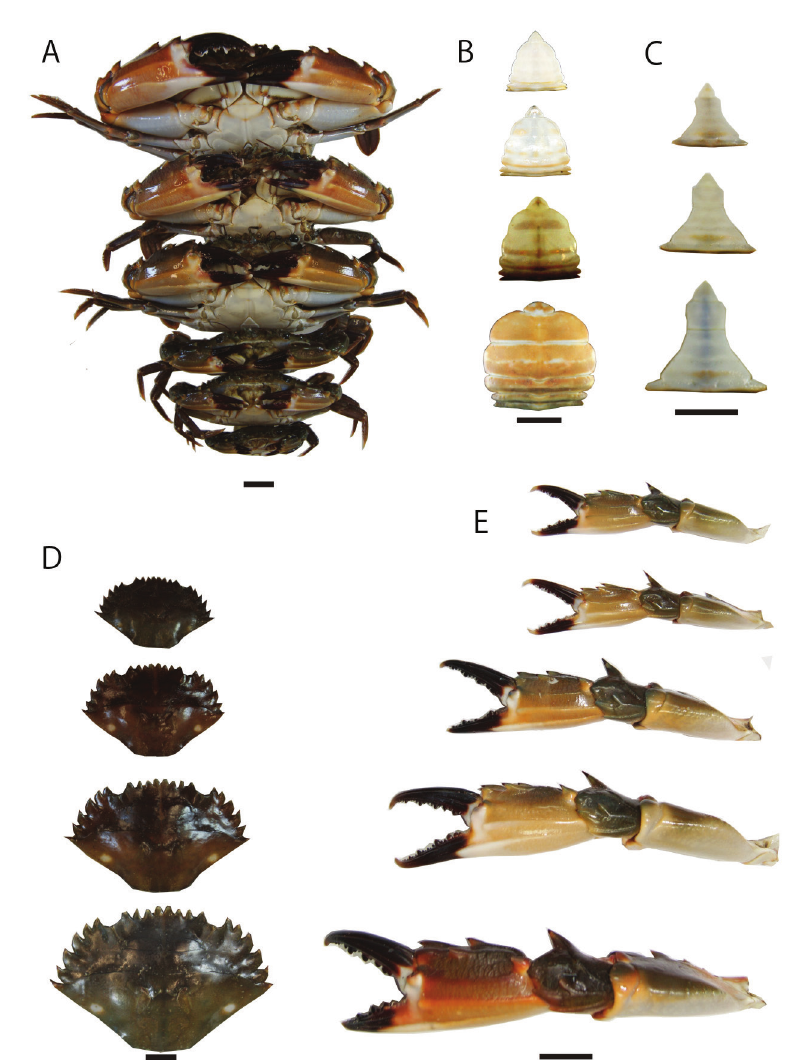
Figure 3 - Visual color variation of Charybdis hellerii related to carapace size and female sexual maturity (abdomen). Scale bar 1 cm. A) Crabs; B) Female abdomen; C) Male abdomen; D) Carapace; and E)